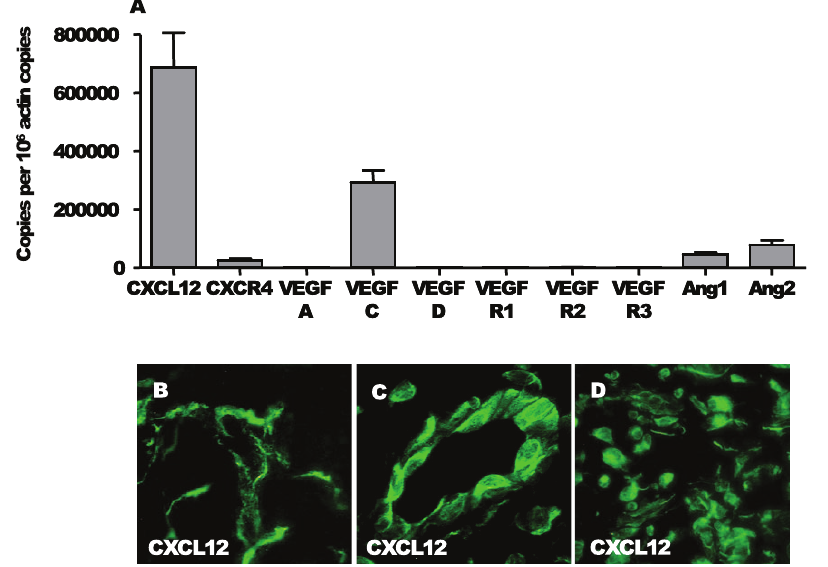
Figure 5. Angio- and lymphangiogenic markers in nodules. (A) A particular pattern of angio/lymphangiogenic factors was established by qPCR in nodules of onchocerciasis patients, characterized by the significant expression of CXCL12, CXCR4, VEGF-C, Angiopoietin-1 and Angiopoietin- 2. Number of analysed nodules=33. Data were analyzed using Prism version 4.0 (GraphPad) and presented as mean 6 SEM. (B-C-D) Expression of CXCL12 in nodule by immunofluorescence. Scales: B, bar=20 m m.